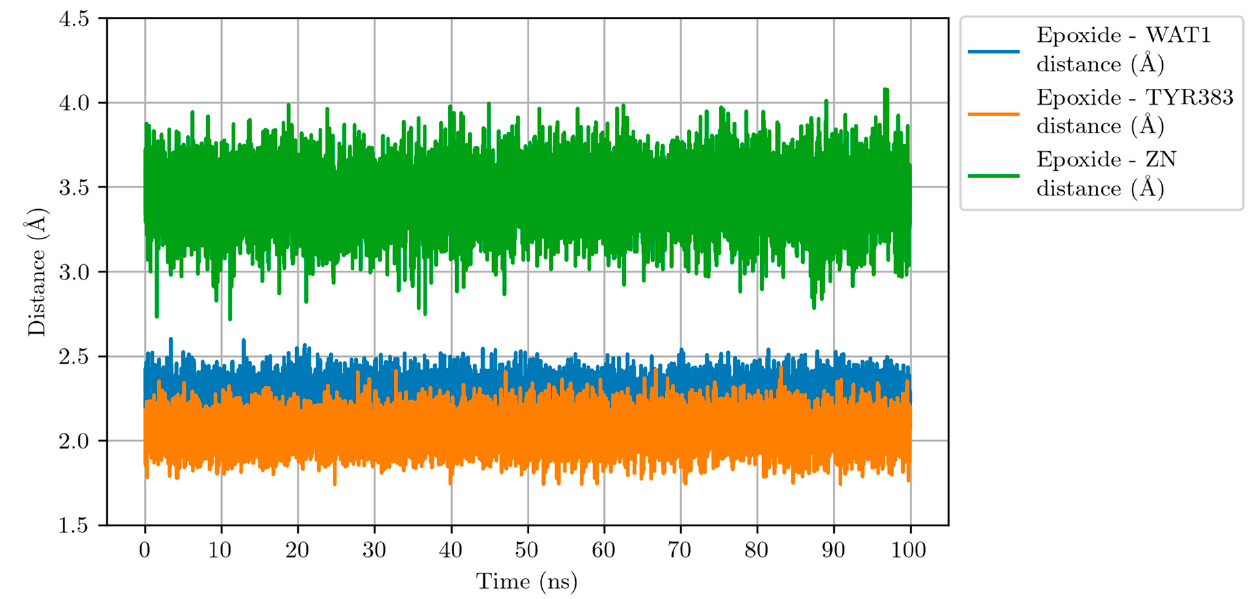
8 of 27 Figure 6. Distances ASP375-WAT (blue points) and C 12 -WAT (orange points) along the Molecular Dynamics simulation for the LTA 4 :LTA 4 H Michaelis complex. WAT stands for a water molecule placed between ASP375 and C 12 .